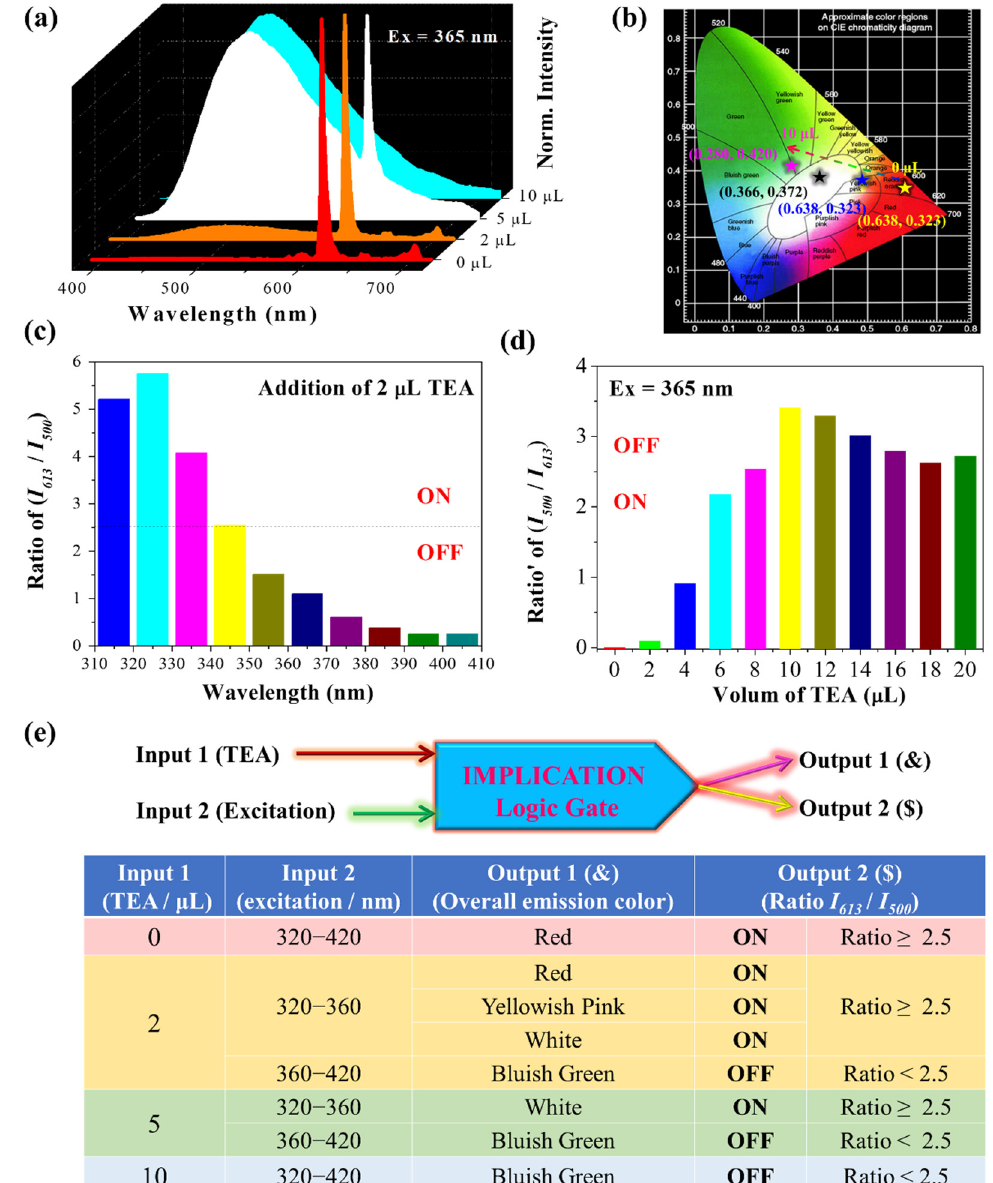
Figure 4. Visible emission spectra ( a ), and corresponding CIE graph ( b ) of complex 2 in DMSO solution stimulated by different amounts of TEA at 1 × 10 − 5 M at RT with the excitation 365 nm. ( c ) corresponding histograms of the fluorescence intensity ratio (R) of 2 at 613 and 500 nm (R = I 613 /I 500 ) with 2 μ L TEA at different excitation. ( d ) corresponding histograms of the fluorescence intensity ratio (R’) of 2 at 613 and 500 nm (R = I 500 /I 613 ) with different amounts of TEA at λ ex = 365 nm. ( e ) The IMPLICATION logic gate dependent on the excitation and amounts of TEA as input signals, and the color of the emission and the ratio intensity as dual output signals.